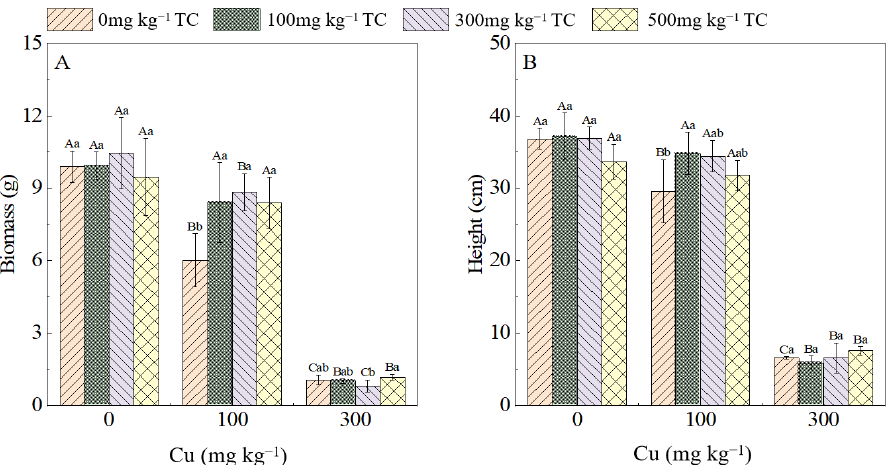
Figure 1. Effect of TC and Cu complex pollution on height and biomass of water spinach. ( A ) biomass; ( B ) height. (Different capital letters represents significant differences between different Cu treatment at p < 0.05, while different lowercase letters represents TC ’ s.).